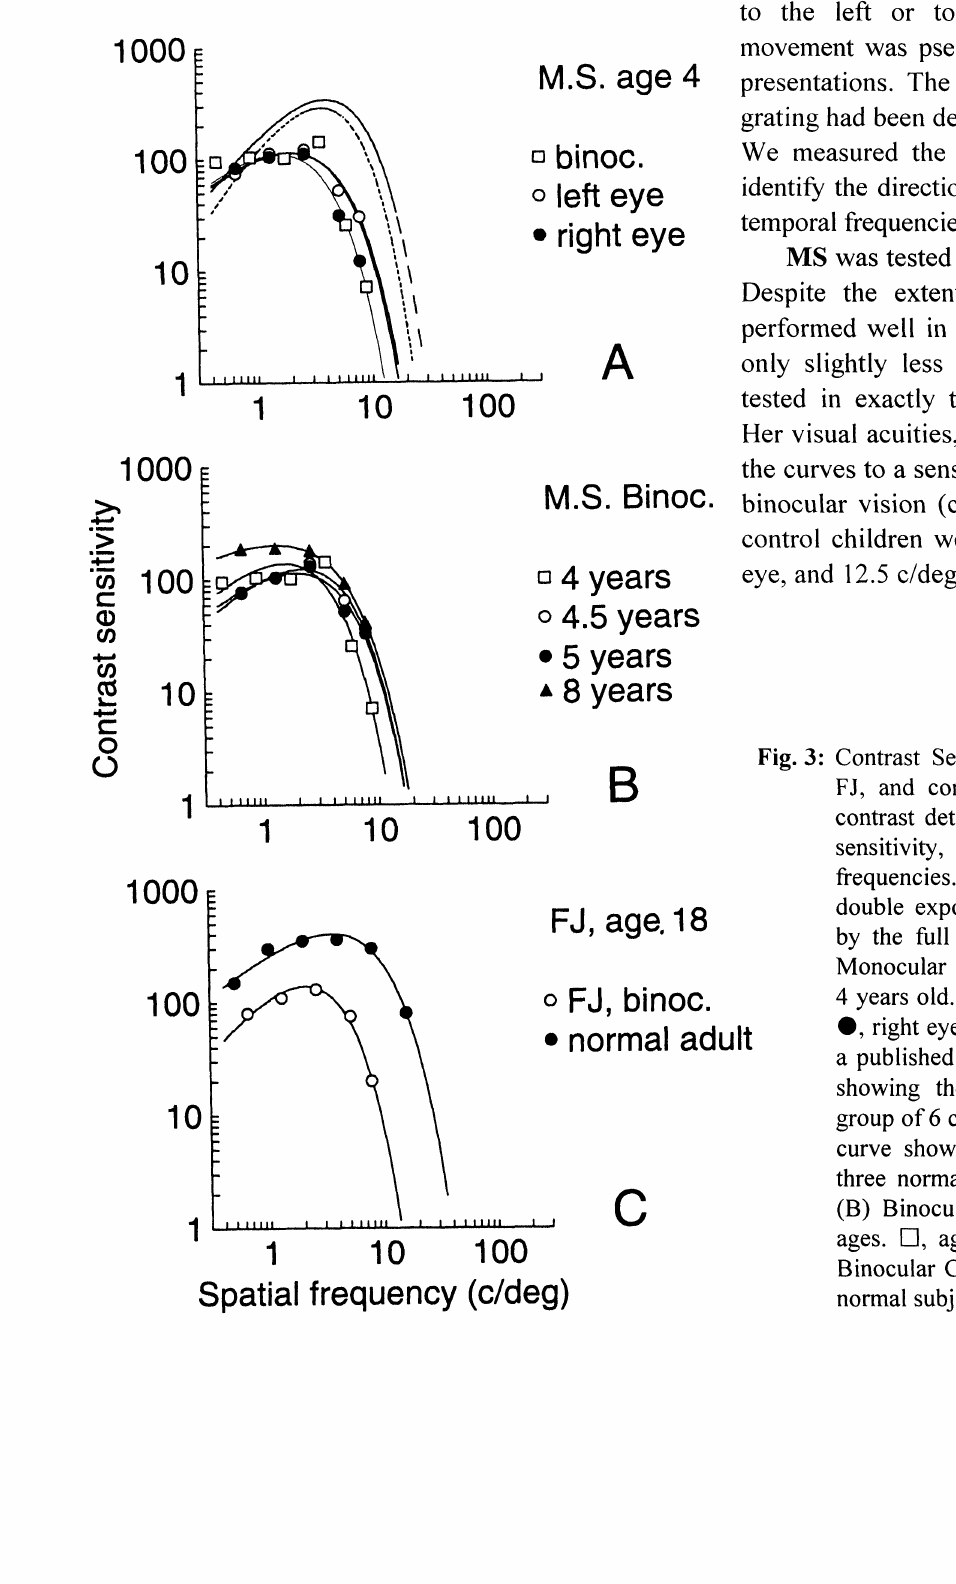
Fig. 3: Contrast Sensitivity Functions (CSF) for MS, FJ, and control subjects. The inverse of the contrast detection thresholds, namely, contrast sensitivity, are plotted for five or six spatial frequencies. Each data set was fitted with a double exponential function (see text), shown by the full lines through the data points. (a) Monocular and binocular CSFs when MS was 4 years old. I-I, binocular viewing; O, left eye; @, right eye. The dashed curves replotted from a published study (Bradley & Freeman, 1982) showing the averaged binocular CSF for a group of 6 children aged 4.5 to 6.5 y. The other curve shows the averaged binocular CSF for three normal control children, aged 4 to 5 y. (B) Binocular CSF for MS at three different ages. F-I, age 4; O, age 4:6; Binocular CSF for FJ at age 18 (O) and for a normal subject